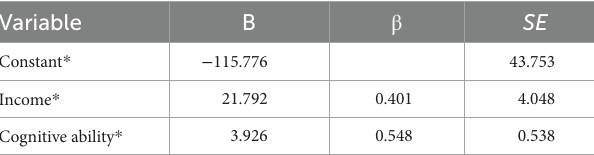
TABLE 2 Results of a regression analysis. Variable